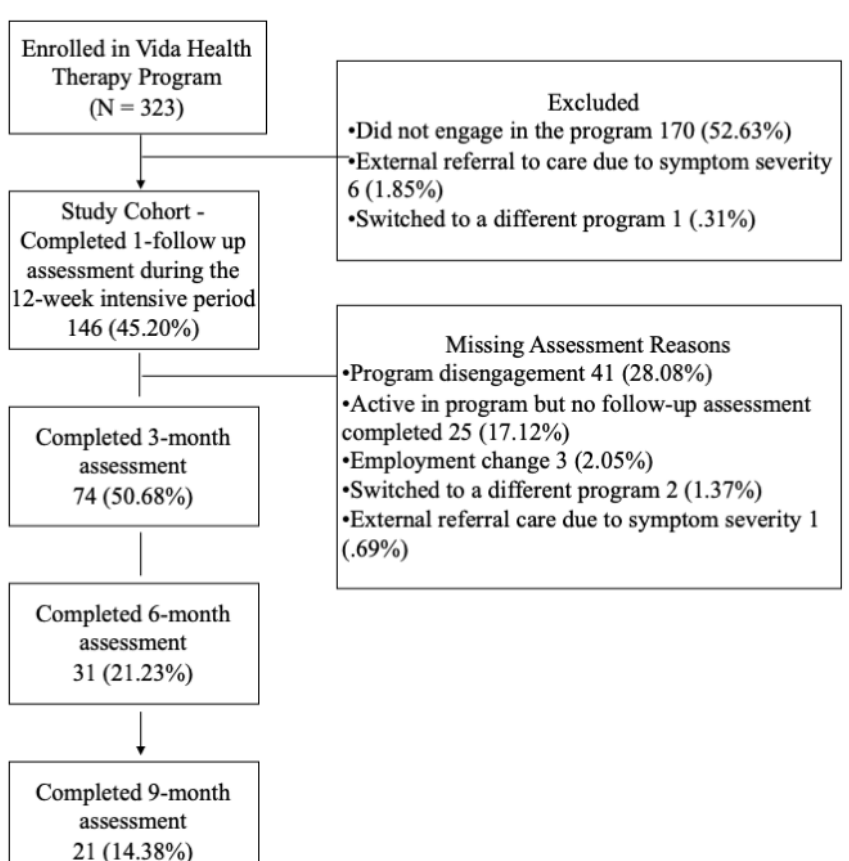
Figure 1. Schematic of participant